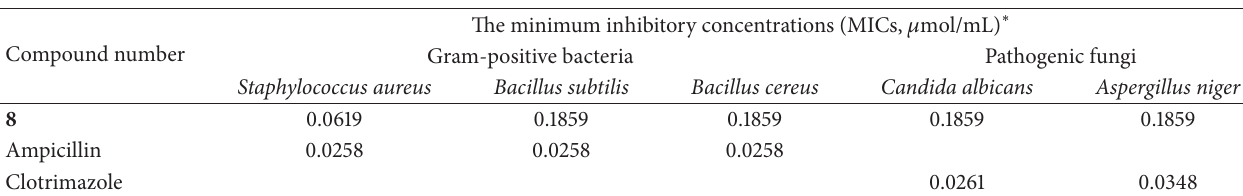
Table 5: The minimum inhibitory concentration (MIC, 𝜇 mol/mL) values for the target compound 8 , ampicillin, and clotrimazole towards the test